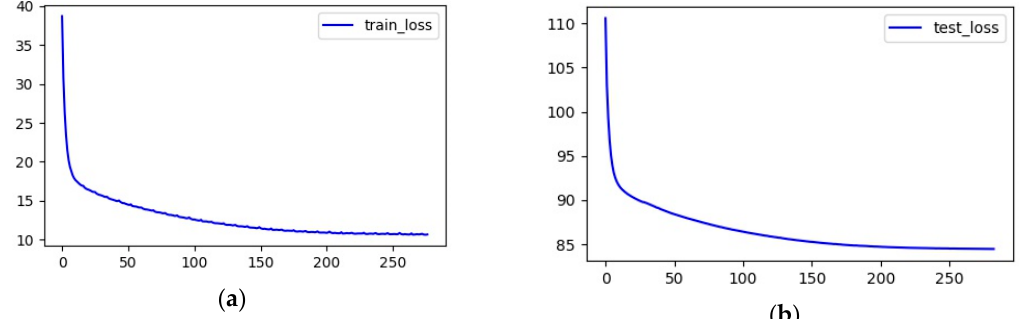
Figure 6. ( a ) The loss curve of the training set; ( b ) the loss curve of the testing set.